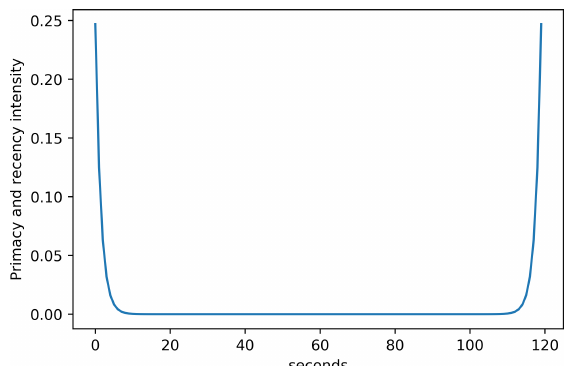
Figure 3. A typical U-shaped curve combined primacy and recency effects.